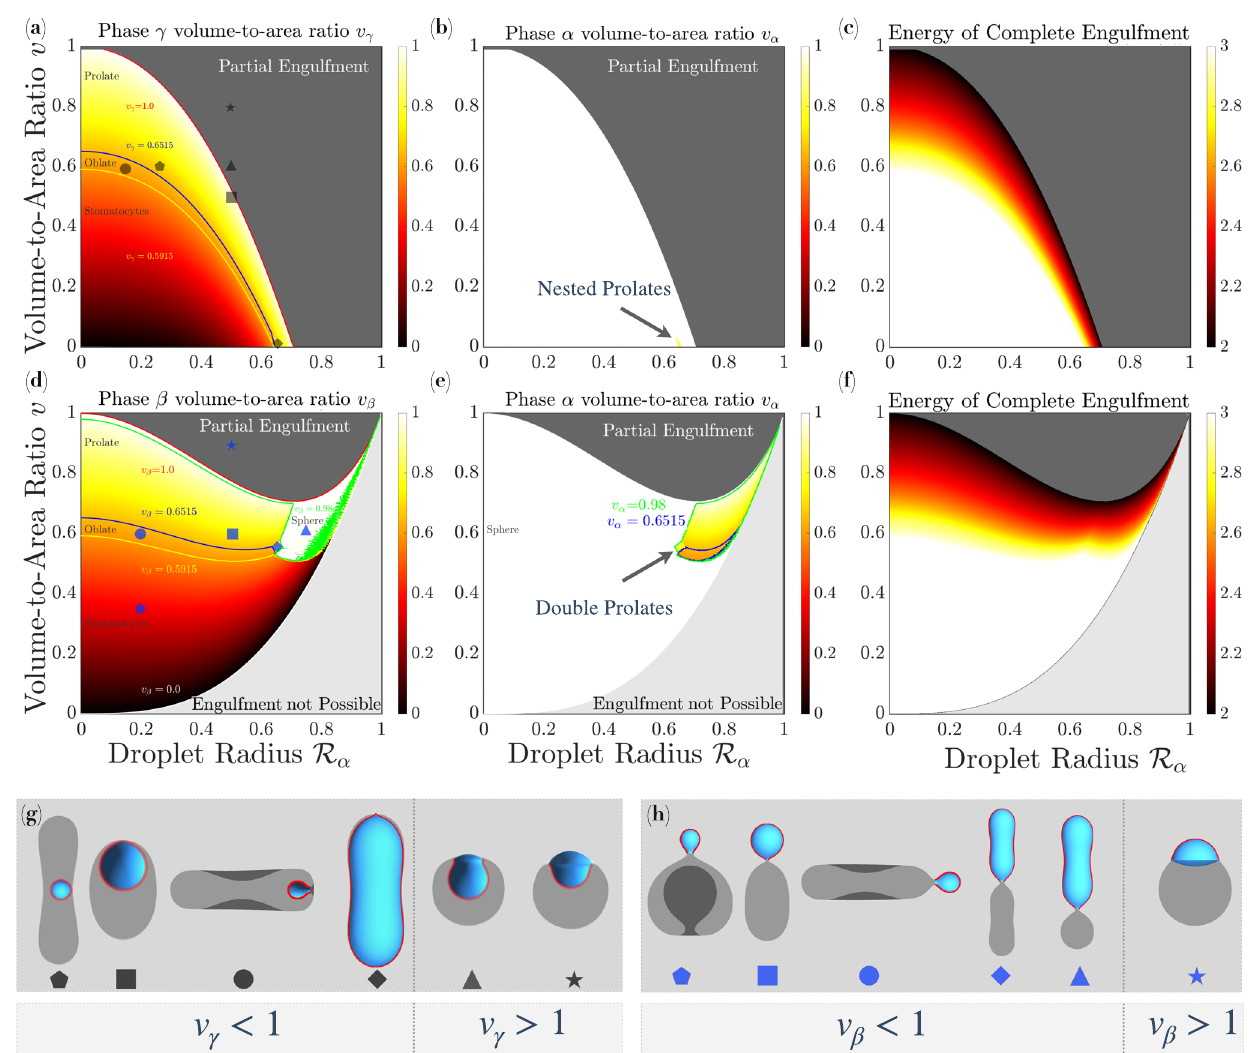
Fig. 2 Volume-to-area ratio of different aqueous phases and complete engulfment energy. ( a ) The γ phase (aqueous phase enclosed inside vesicle) volume-to-area ratio v γ for droplet endocytosis. ( b ) The droplet α phase volume-to-area ratio v γ for droplet endocytosis, and ( c ) the total elastic energy ð E þ E Þ = 8 πκ for droplet endocytosis after complete engulfment. Above v γ > 1 only partial engulfment is possible, shown by the dark gray region. ( d ) The αγ βγ phase β (aqueous phase enclosed inside vesicle) volume-to-area ratio v β for nanodroplet exocytosis. ( e ) the droplet α phase volume-to-area ratio v α for nanodroplet exocytosis, and ( f ) The total elastic energy for nanodroplet exocytosis after complete engulfment. Above v β > 1 only partial engulfment is possible, shown by dark gray region and no engulfment is possible below v β < 0 shown by light gray region. ( g ) The typical morphology obtained for droplet endocytosis, the symbols corresponds to the parameter space in ( a ). ( h ) The typical morphology obtained for nanodroplet exocytosis, the symbols corresponds to the parameter space in ( d ). The vesicle radius is R ve = 1 μ m , the bending rigidity of the vesicle is κ = 20 k B T , the spontaneous curvature is zero, and the interfacial tension of the nanodroplet is Σ αβ = 17.5 μ Nm − 1 , Shape transformation by droplet endocytosis . Here we study value, where interfacial energy is equal to bending energy of the wetting-induced shape transformations of vesicles for different sphere Σ αβ = (8 πκ )/ A αβ , a complete engulfment is observed (blue nanodroplet sizes and interfacial tensions. For the volume-to-area region in Fig. 3a). Critical interfacial tension locates the limit ratio v γ < 1 of the γ phase, for which complete engulfment is shapes on the morphology diagram, where the membrane neck possible, we observed three different regions with different wet- closes (black line in Fig. 3a). In the complete engulfment region, ting and morphological features. First, for small nanodroplets and the nanodroplet is engulfed from the equator, and the daughter very low interfacial tensions, the nanodroplet partially wetted the vesicle takes the prolate shape. For v γ > 1, we only observed partial wetting and partial engulfment. The latter is due to the vesicle and did not change the prolate morphology of the vesicle lack of membrane area for complete engulfment (the light gray (the green region in Fig. 3a). For a range of parameters shown in region in Fig. 3a). For very low interfacial tension, the nano- the pink region in Fig. 3, wetting of the vesicle induced shape droplet wetted the vesicle from the pole and did not affect the transformation from prolate to oblates or stomatocytes, and morphology due to ultra-low interfacial energy. However, for vesicle partially engulfed the nanodroplet. Two shapes have the large interfacial tension, the interfacial energy dominated and same free energy on the transition line (dash-dotted brown lines changed the morphology from prolate to stomatocytes to reduce in Fig. 3a). However, for interfacial tension larger than the critical